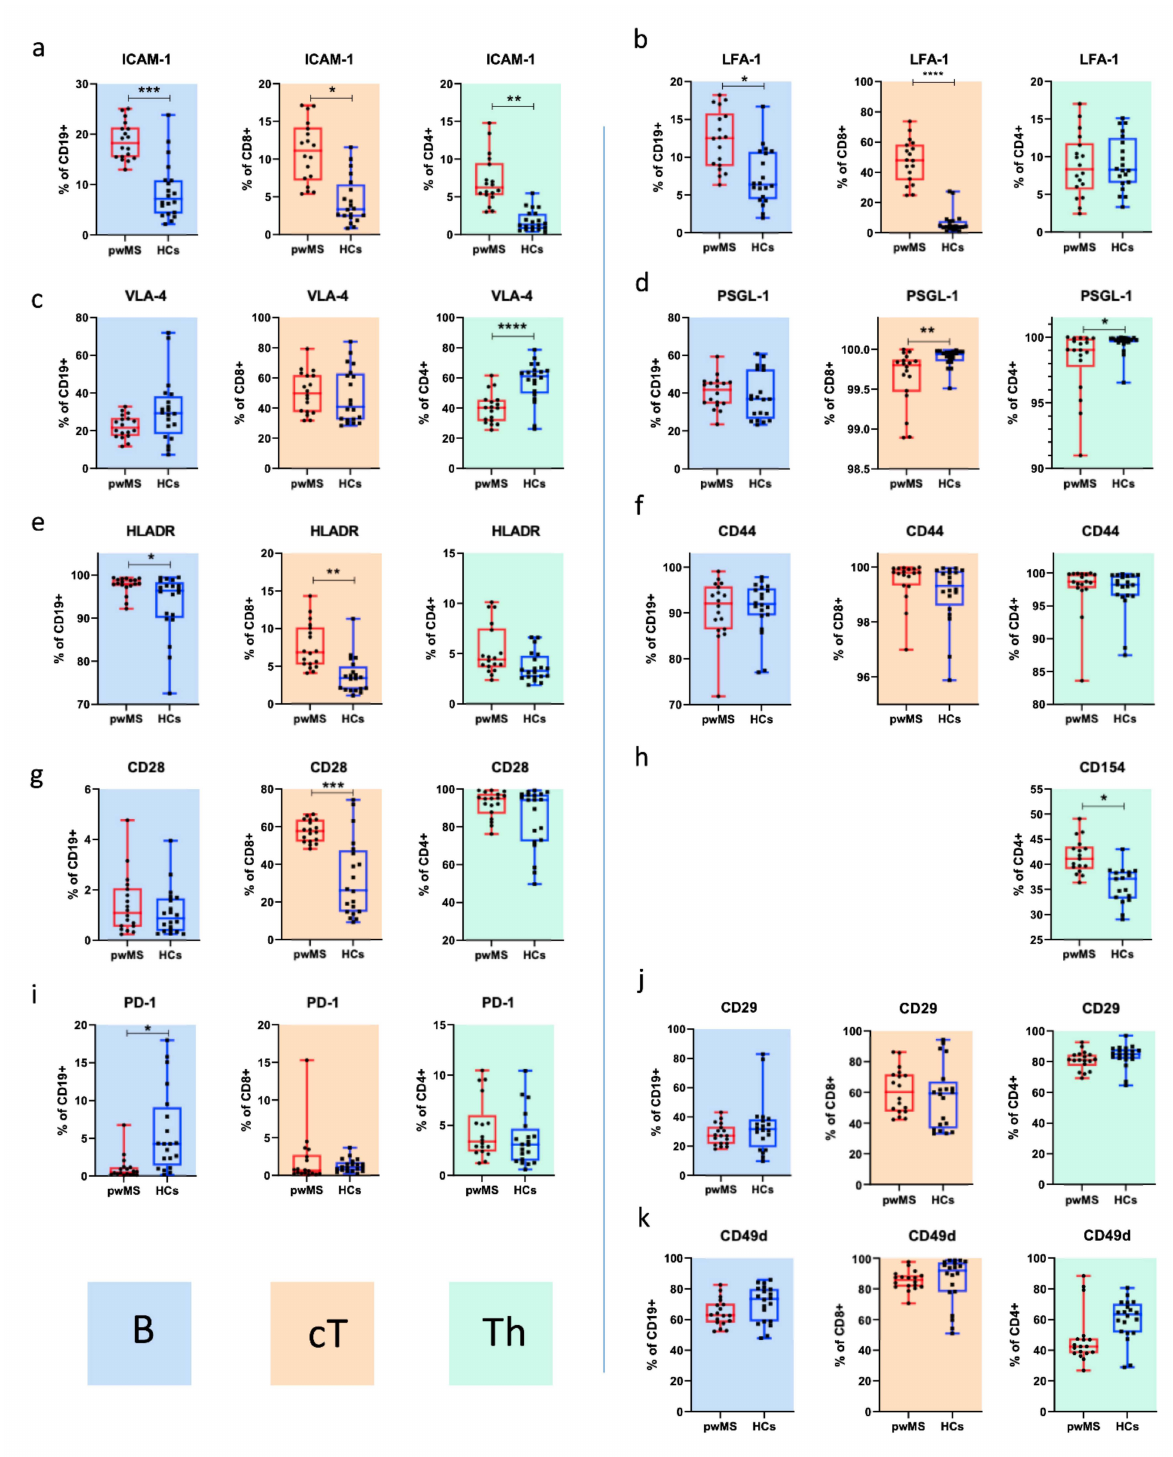
Figure A1. Baseline characteristics of adhesion and costimulatory surface molecules in HCs and pwMS ( a – k ) as measured by flow cytometry: frequencies of B cells/CD19+ (blue graphs), cytotoxic T cells/CD8+ (brown graphs) and T helper cells/CD4+ (green graphs). For intracellular staining with CD154, cells were stimulated for 6 h, fixed and permeabilized. We found a pro-migratory and -inflammatory profile characterized by a higher percentage of ICAM-1 (CD19+, CD4+ and CD8+ ( a )), LFA-1 (CD19+ and CD8+ ( b )), HLADR (CD19+ and CD8+ ( e )), CD28 (CD8+ ( g )) and CD154 (CD4+ ( h )) expressing immune cells. Legends: Box-and-whisker plots show the median, interquartile range and minimum–maximum range. * p ≤ 0.05, ** p ≤ 0.01, *** p ≤ 0.001 and **** p ≤